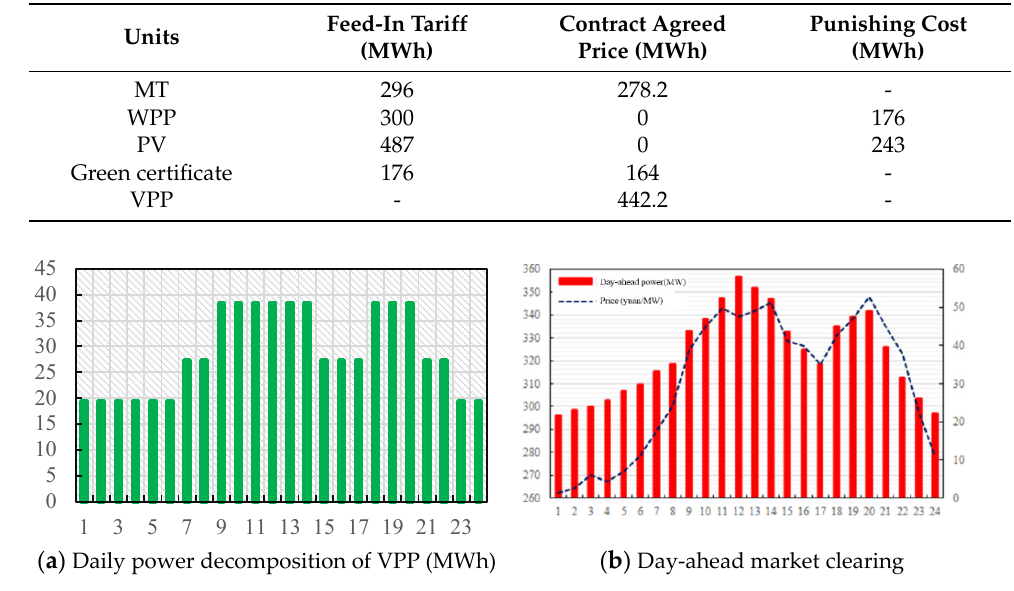
Figure 5. Daily electricity decomposition of VPP and market clearing. Table 2. Unit price setting of VPP (Yuan).